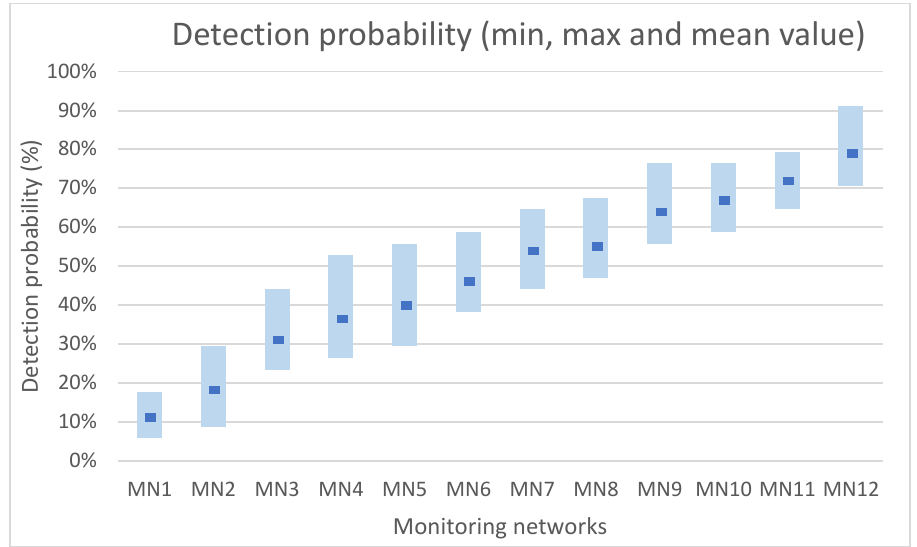
Figure 4. Detection probability minimum, maximum and mean values for monitoring networks (consisting of nodes for installation of sensors based on Ο 4 objective).